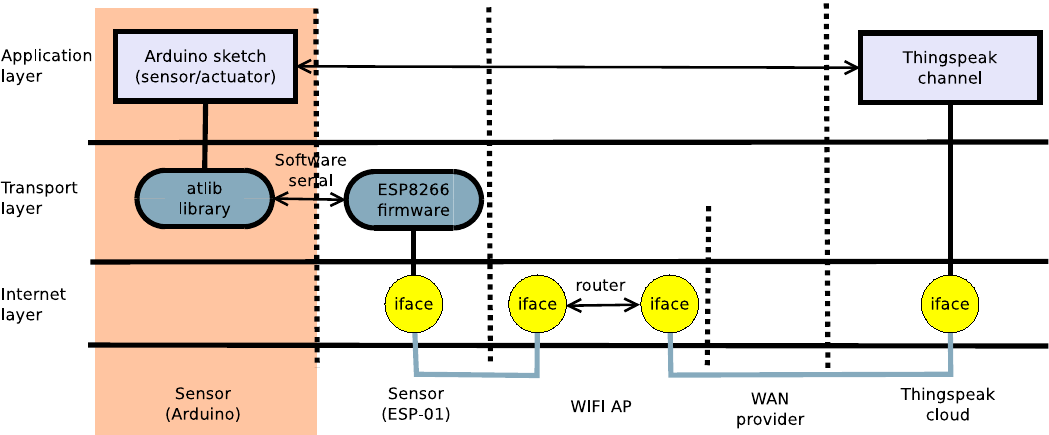
Figure 2. The proposed architecture envisions application level communication between the sensor and the service provider, thus reducing development